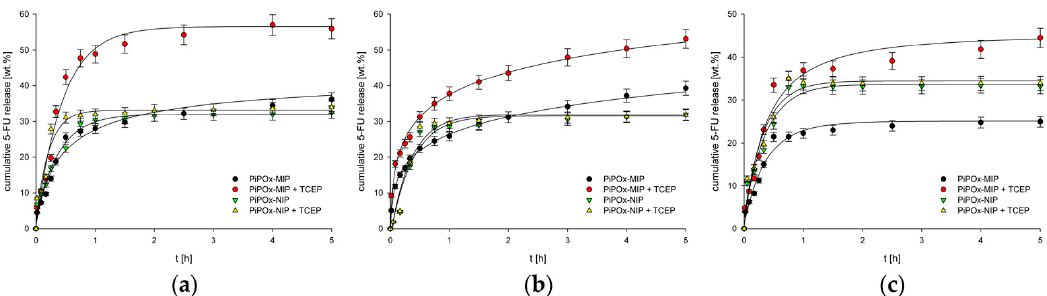
Figure 7. Release profiles of 5-FU from drug loaded PiPOx-MIPs and NIPs at ( a ) pH 7.4; ( b ) pH 6.5; ( c ) pH 2.0. Reproduced with permission from Ceglowski et al. [47].